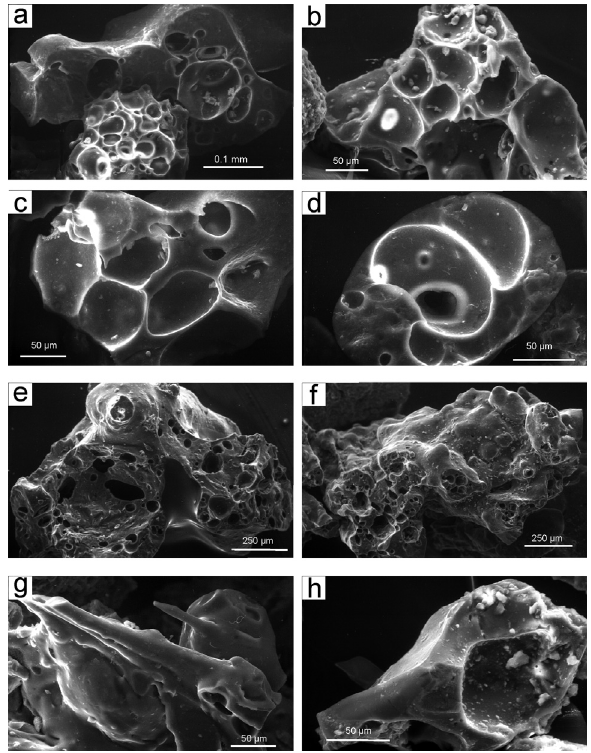
Figure 4. SEM images of ash fragments in the lapilli beds (AS 95 44 and 47), showing the morphological features.